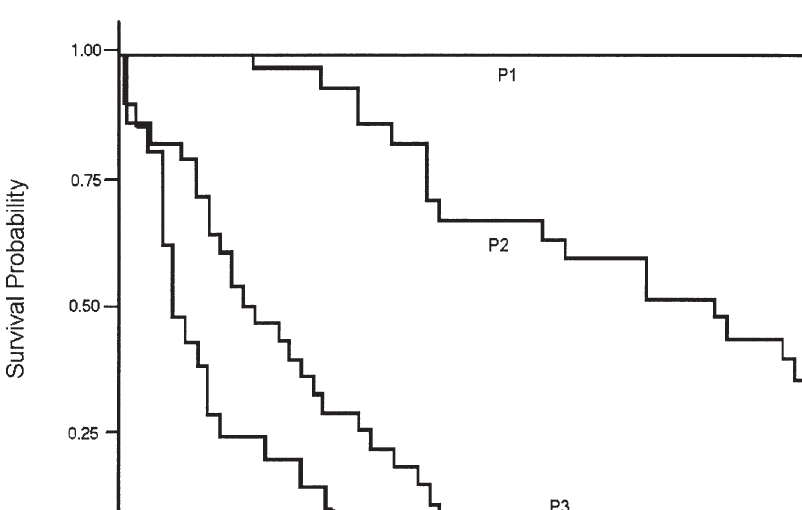
Fig. 1. Prognostic index and dead risk.